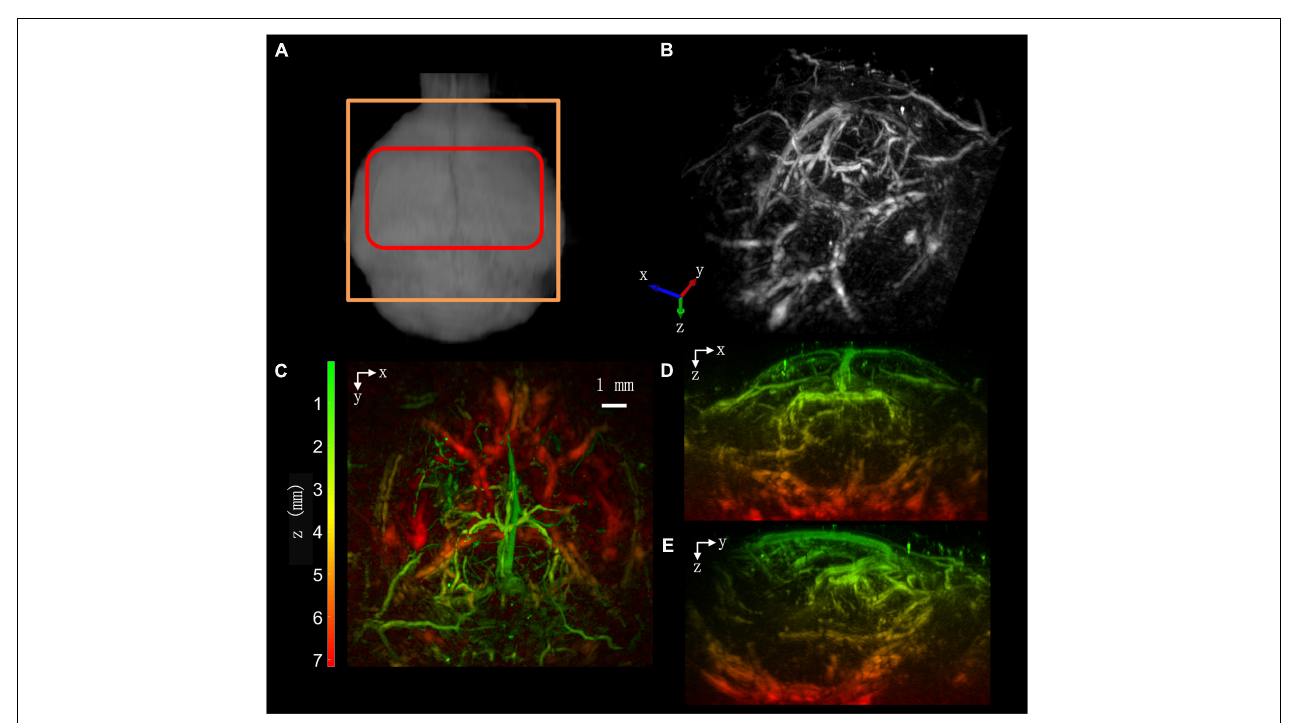
FIGURE 3 | Imaging results: (A) imaging area (shown in orange) and position of the cranial window (shown in red). (B) MIP of the 3D imaing result from inclined top view. (C) MIP of the imaing result in x-y plane. (D) MIP in x-z plane. (E) MIP in y-z plane. (C–E) Are color coded along the z direction.